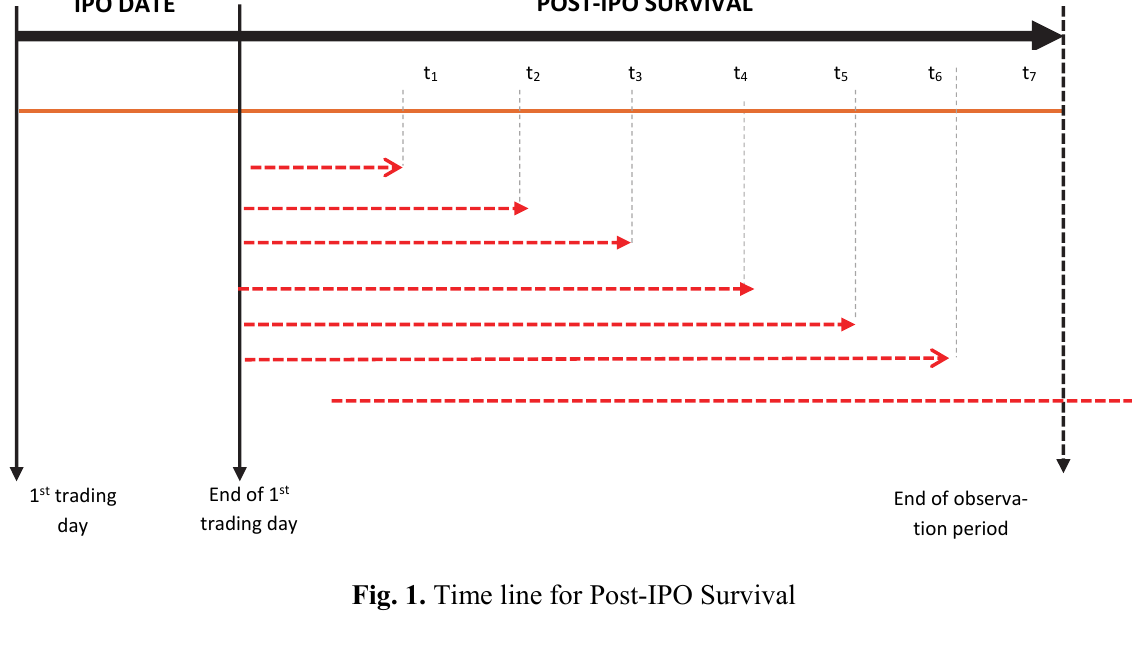
Fig. 1. Time line for Post-IPO